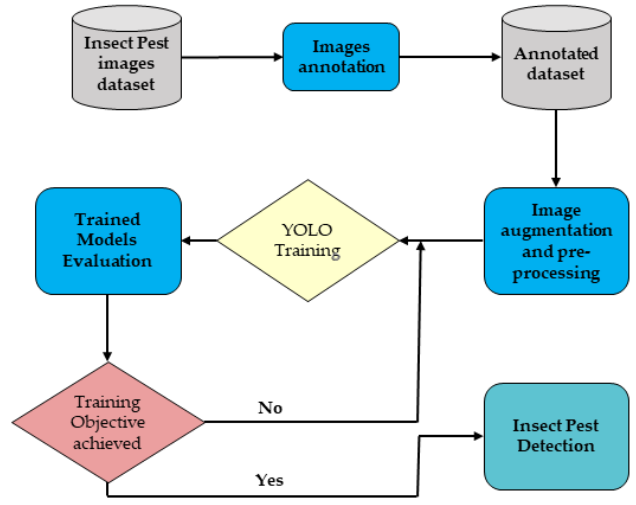
Figure 1. Schematic flowchart of the research approach. Table 1. Details of the collected IP-23 images